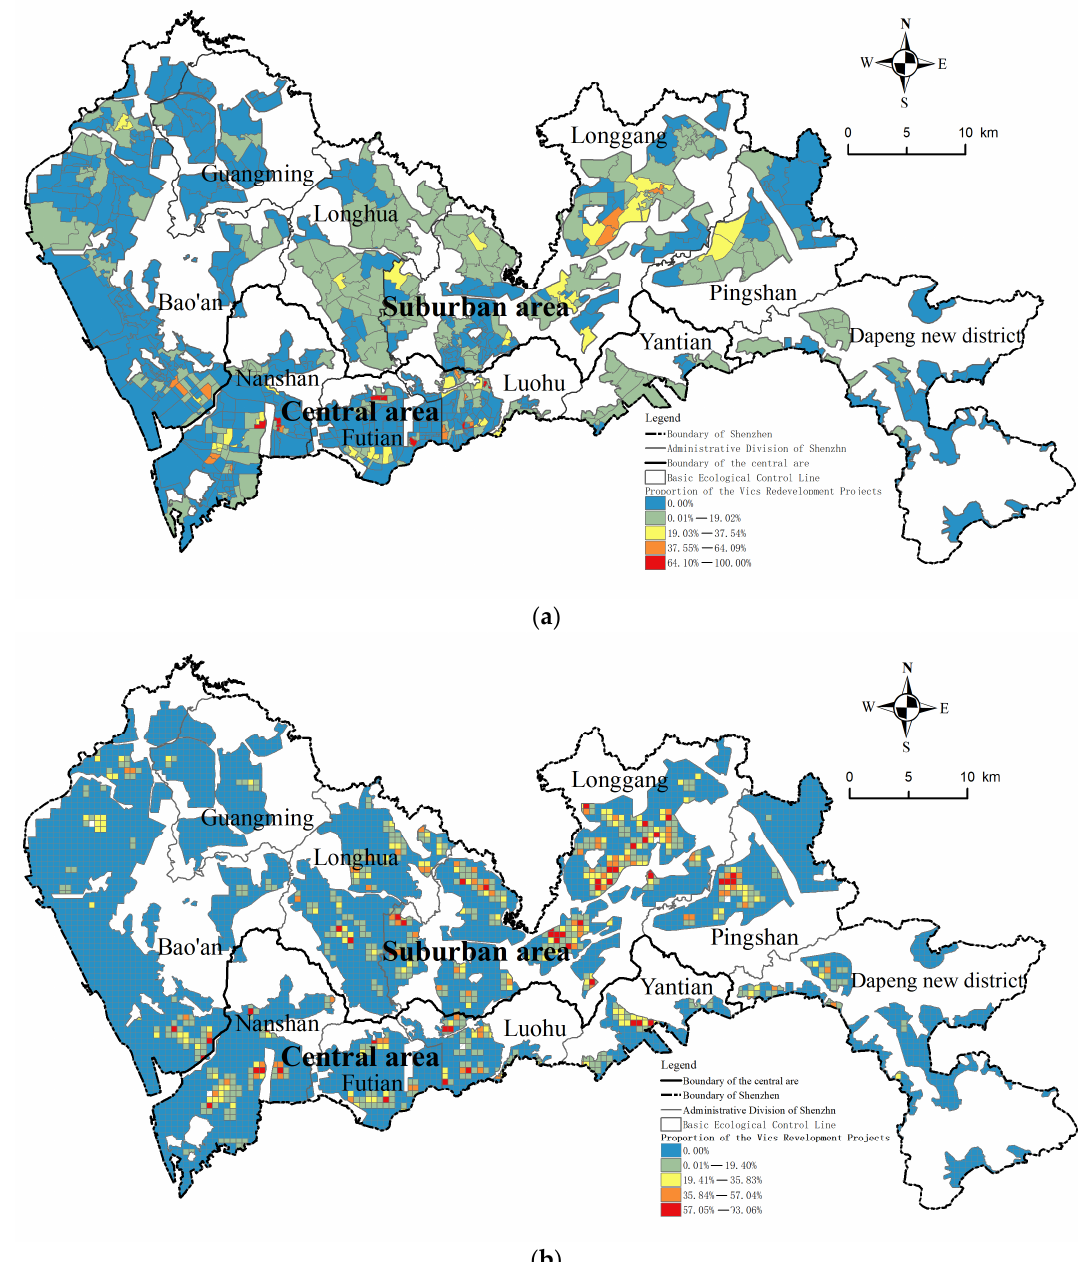
Figure 4. ( a ) Proportion of urban village redevelopment project area per community; ( b ) proportion of urban village redevelopment project area per 0.5 km × 0.5 km grid.